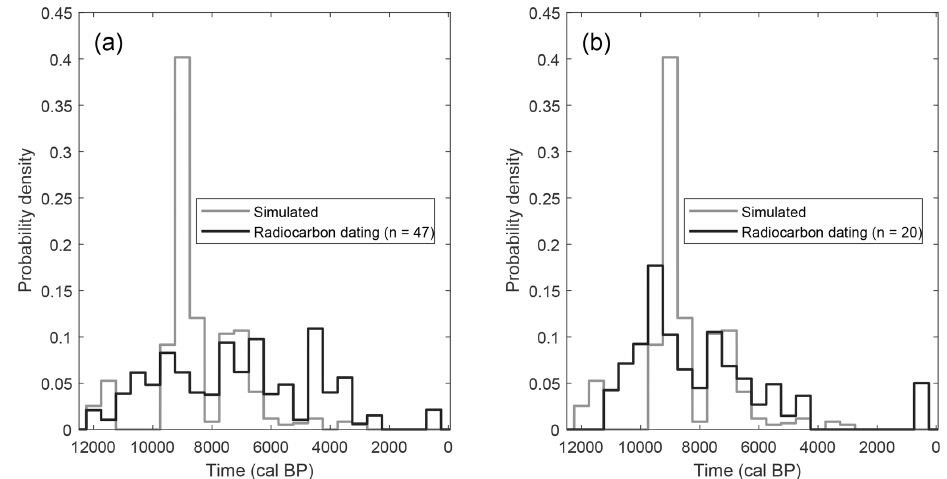
Figure 10. Probability density function of the peat growth initiation dates based on the model simulation and the radiocarbon dating database for Scottish upland areas (above 300ma.s.l., see Appendix A2) using a bin width of 500 years. (a) All dates. (b) All dates, excluding those for which a date was obtained by extrapolating an age–depth model to the bottom of the peat column.